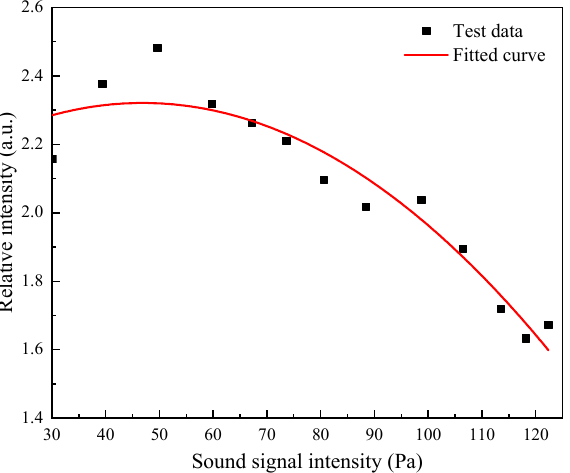
Figure 13. Plot of demodulated signal intensity versus sound wave signal intensity.